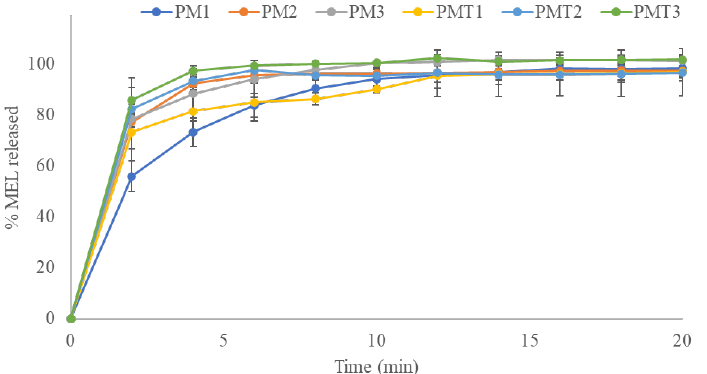
Figure 8. In vitro release profiles of MEL-loaded PVA nanofibers Melatonin-loaded PVA nanofibers with different concentration of drug 0.1% w/w (PM1), 0.3% w/w (PM2), 0.5% w/w (PM3), and Melatonin- loaded PVA nanofibers with Tween ® 80 and different concentration of drug 0.1% w/w (PMT1), 0.3% w/w (PMT2), 0.5% w/w (PMT3) in phosphate buffered solution (pH 7.4) at 37 °C. Each point represents the mean value of three different experiments ± S.D. Table 3. Dissolution kinetic parameters of Melatonin-loaded PLA and PVA nanofibers. Sample